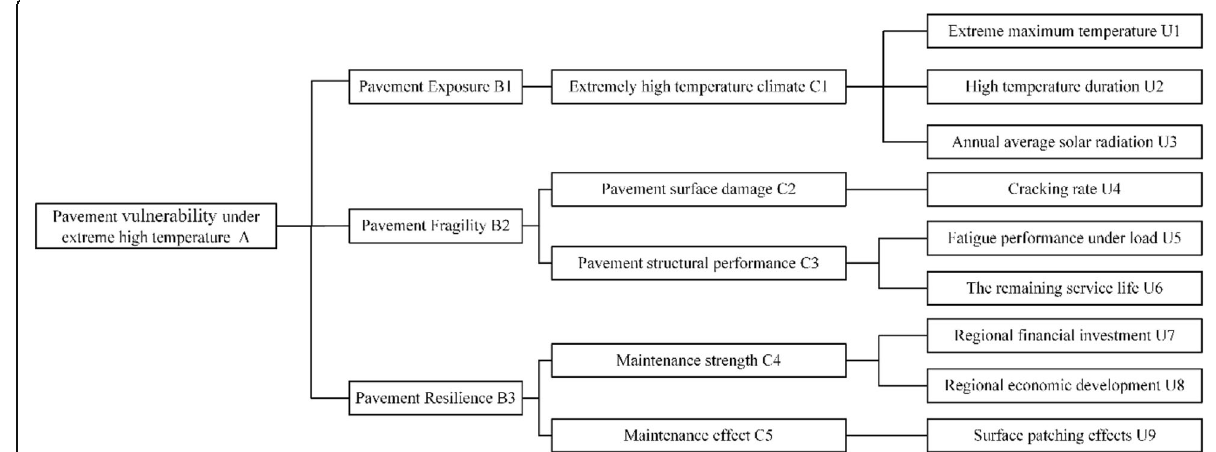
Fig. 5 Assessment index system of asphalt pavement under extreme high temperature climate